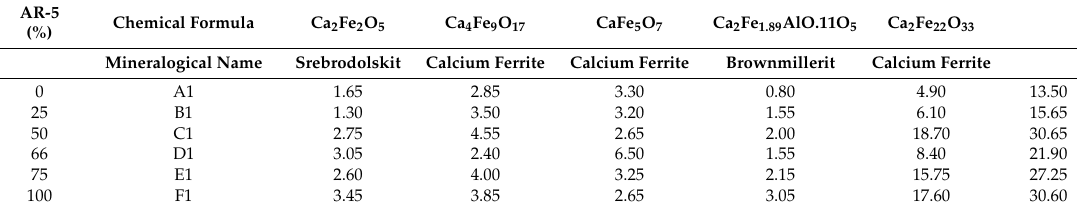
Table 8. Phase composition of agglomerates—calcium ferrites.